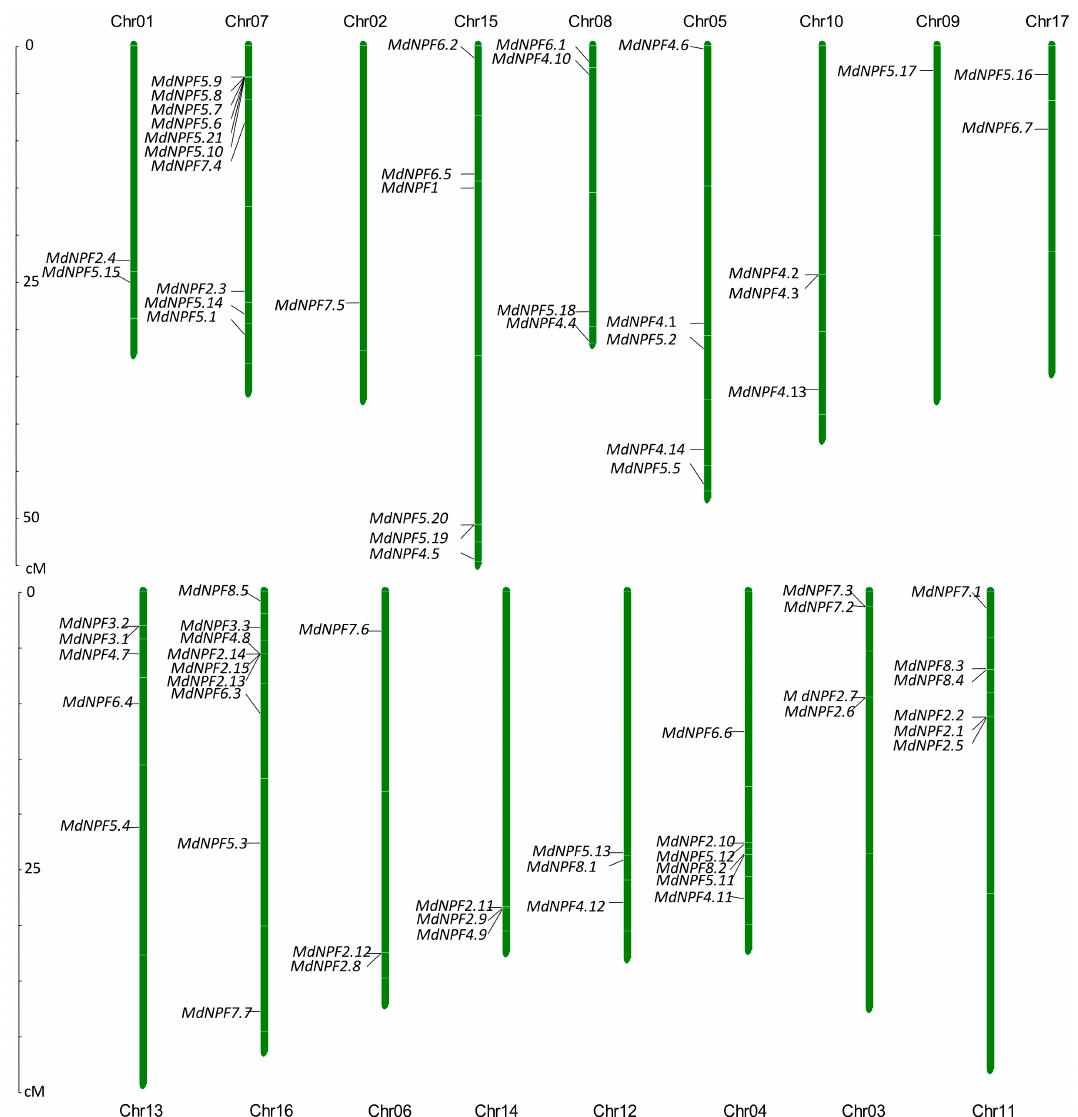
Figure 2. Chromosome positions for MdNPF genes, marked with solid black lines. Scale on left is in Mb. Chromosome numbers are indicated on top of bar.